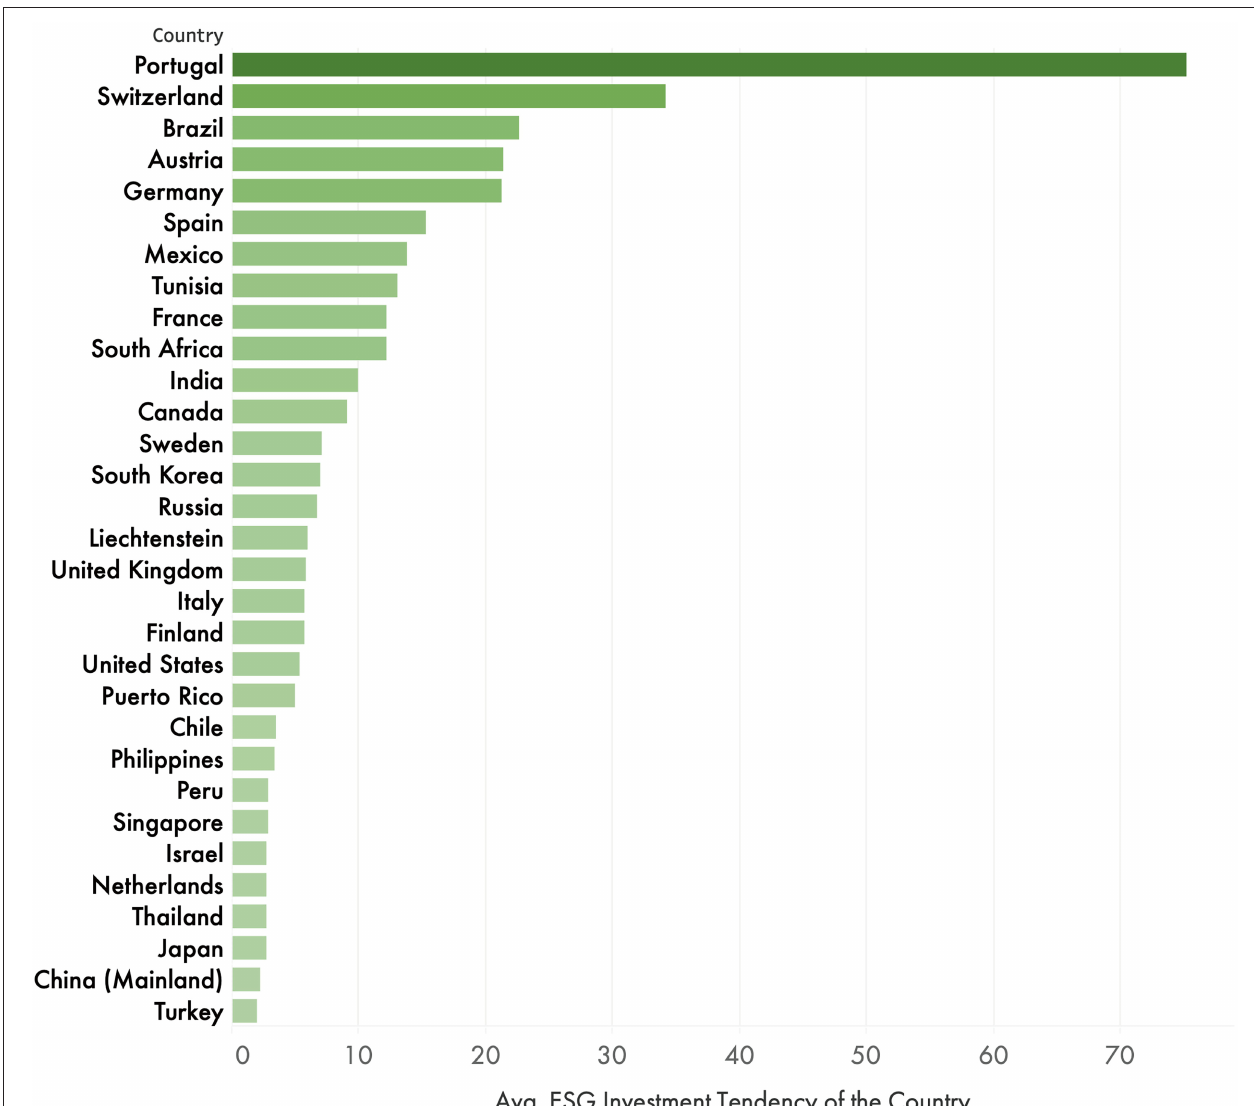
FIGURE 10 | Average ESG tendency by